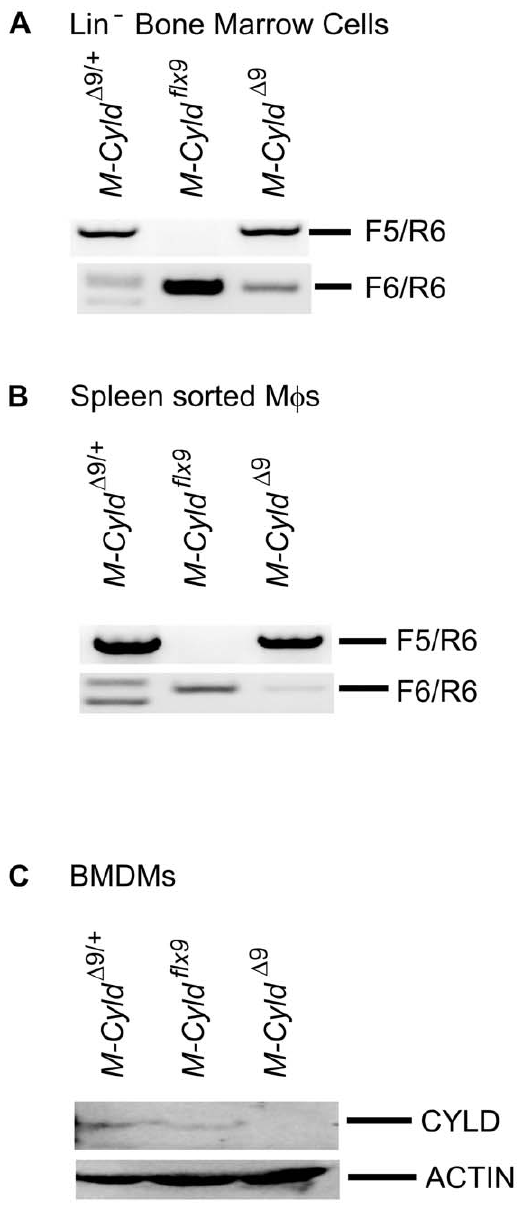
Figure 1. Generation and characterization of mice with inactivation of CYLD specifically in myelomonocytic cells. Cyld recombination is detected by genomic PCR in Lin 2 precursor cells isolated from bone marrow (A) as well as in mature macrophages sorted from spleen (B). C) Immunoblotting of whole cell extracts from BMDMs isolated from control and M-Cyld D 9 mice with anti-CYLD and anti-ACTIN antibodies.